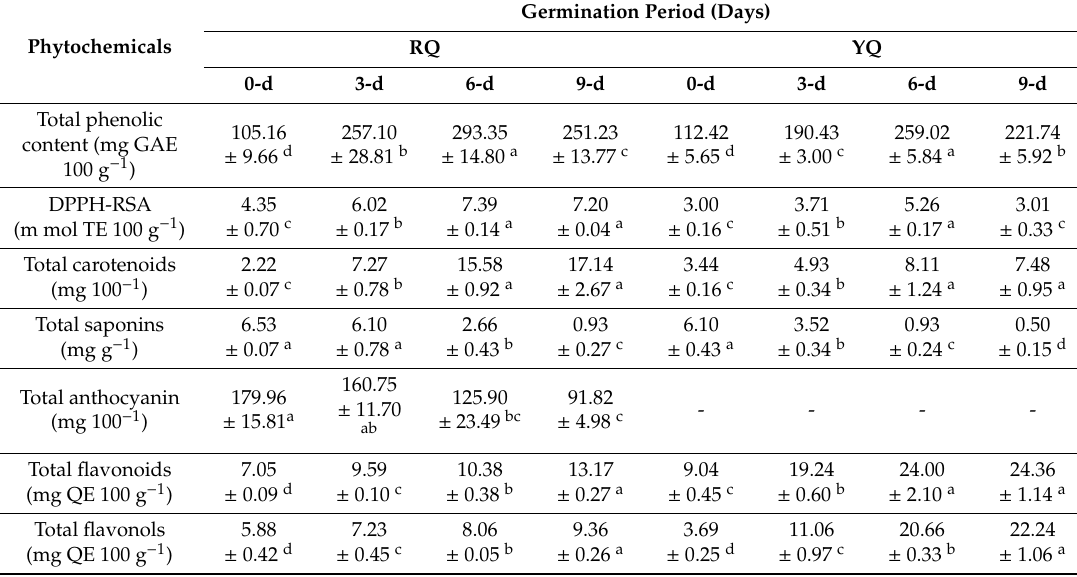
Table 1. Phytochemical content in yellow and red quinoa seeds and sprouts during 9 days of germination at 17 ± 1 ◦ C and 90–93% relative